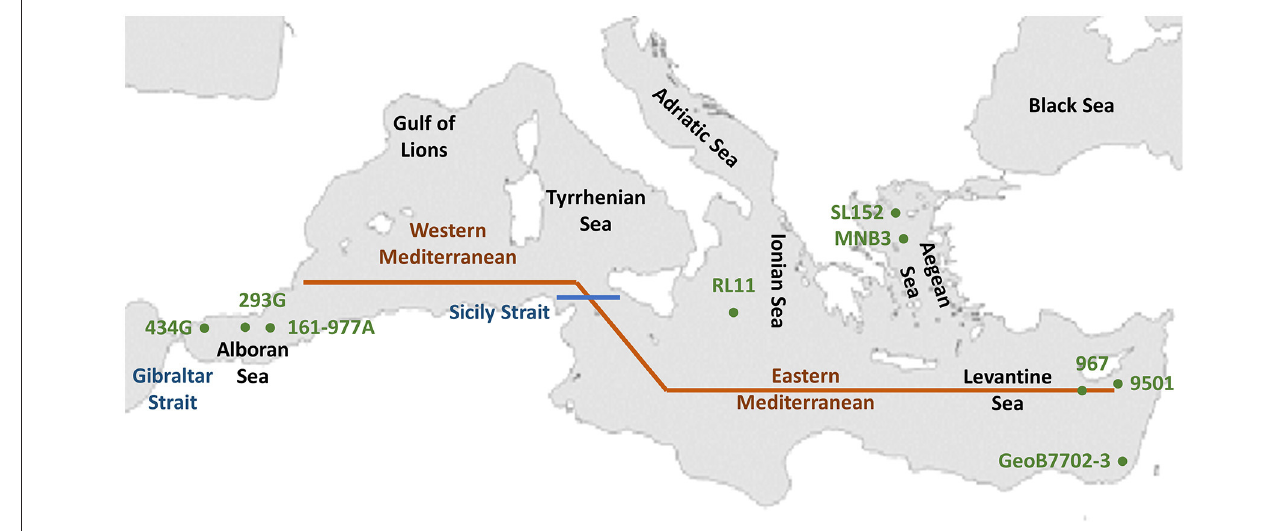
FIGURE 2 | Marine core sites and transects used in the present study.